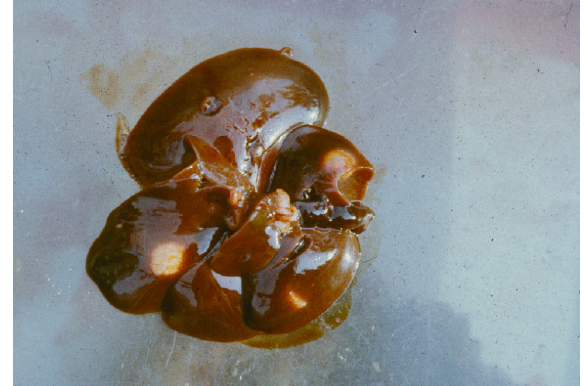
Figure 8. Three cysts of Strobilocercus fasciolaris the larval stage of Hydatigera taeniaeformis in the liver